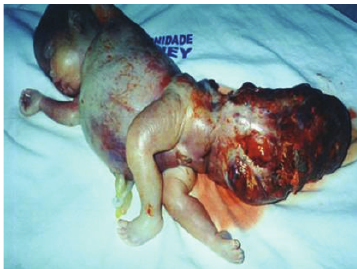
Figure 3: Image of a stillborn fetus showing hydrops and a large sacrococcygeal teratoma in which solid components